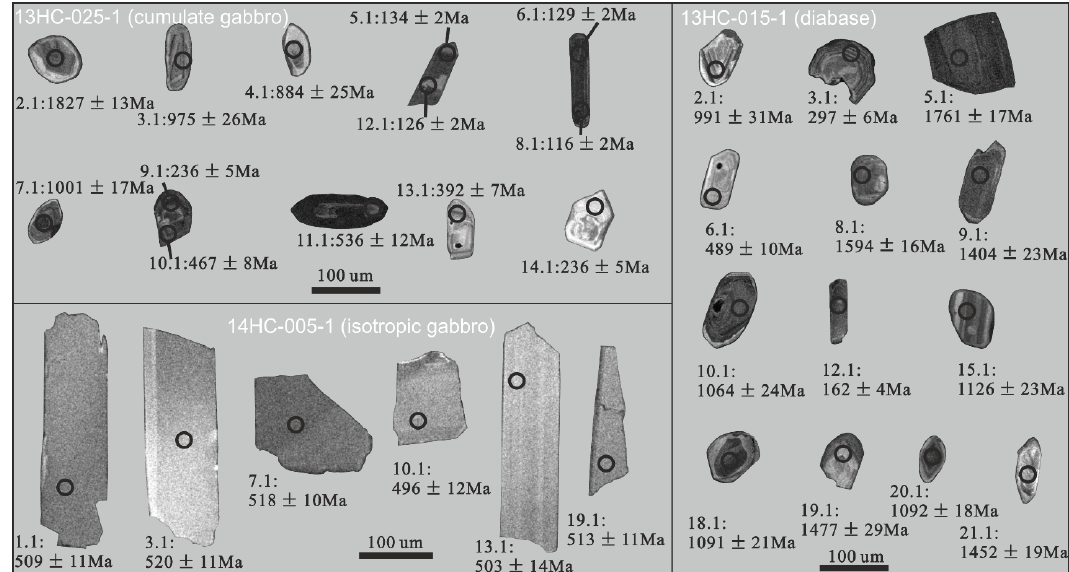
Figure 5. CL images for representative zircon crystals (black circles represent analyzing spots).